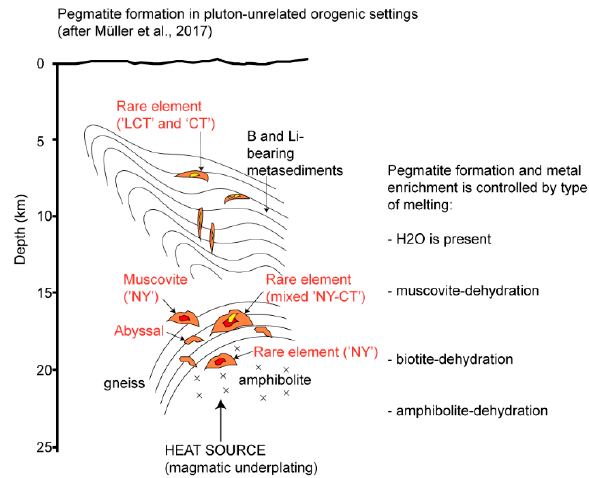
Figure 3. Simplified model of anatectic pegmatites formed in orogenic settings characterised by a distinct lack of nearby granite plutons (modified from [13]).